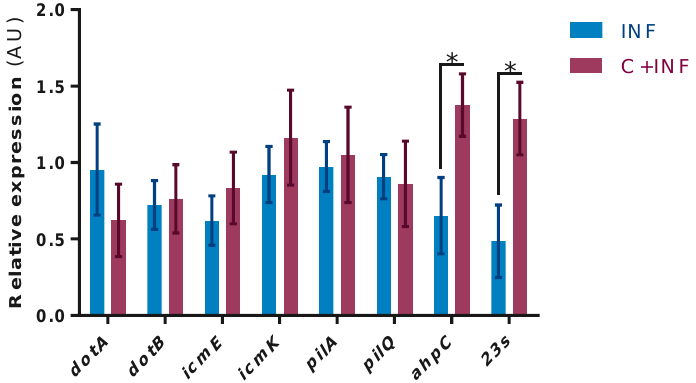
Figure 4. Bacterial gene expression between infected myotubes with cortisol pretreatment. Pathogenesis-related gene expression by RT-qPCR of P. salmonis : Dot/Icm ( dotA, dotB, icmE, icmK ), type 4 pili ( pilA, pilQ ), thiol-specific peroxidase ( ahpC ), and bacterial load ( 23s ). Data were normalized against sdhA and gyrB and are expressed in arbitrary units (AU) as the mean ± SEM ( n = 3). The “*” indicates significant differences between INF vs. C+INF ( p < 0.05). Abbreviations: INF, infection; C+INF, cortisol+infection; dotA , deficient in organelle trafficking A; dotB , deficient in organelle trafficking B; icmE , intracellular multiplication E; icmK , intracellular multiplication K; a hpC , alkyl hydroperoxide reductase C; sdhA , succinate dehydrogenase A subunit; gyrB , DNA gyrase B subunit.